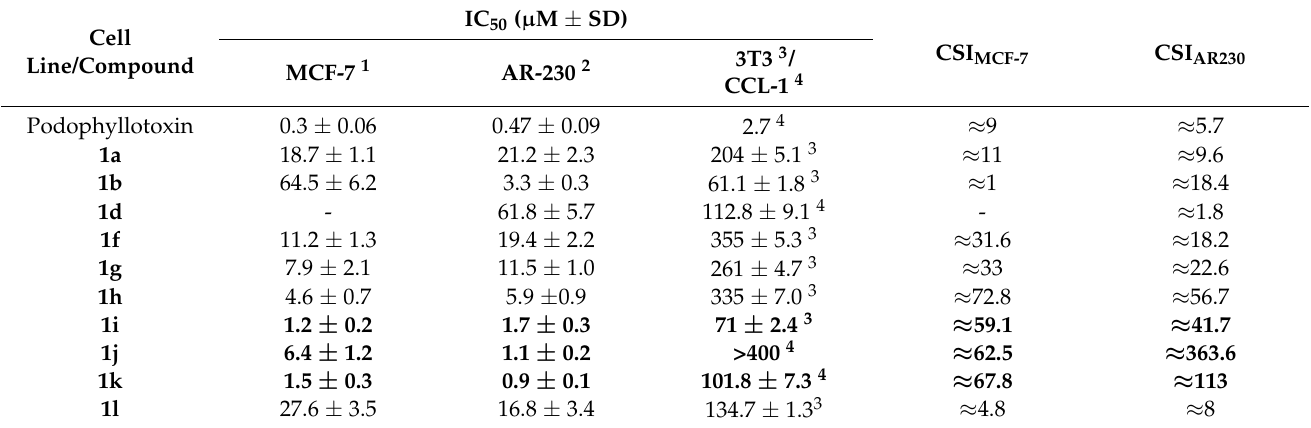
Table 2. In vitro cytotoxicity of 1H-benzimidazole-2-yl hydrazones 1 a-l against cell lines of differ- ent origin.